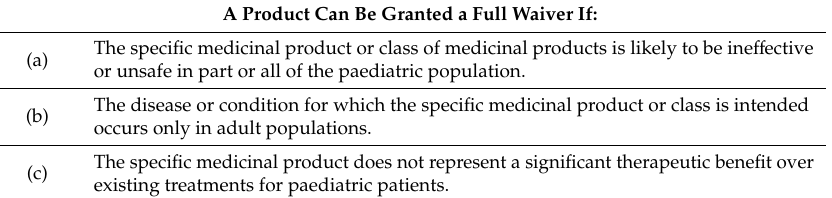
Table 6. Conditions for a product to be considered for a full waiver by the PDCO as stated in the EUPR